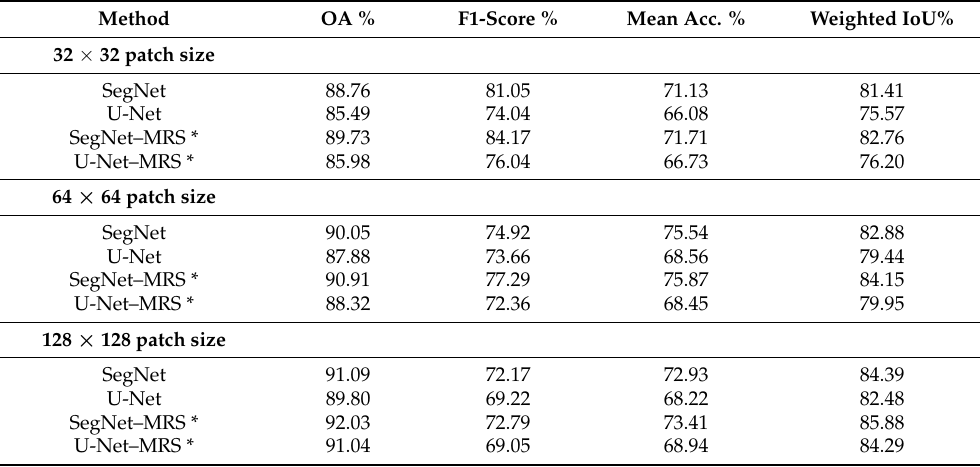
Table 15. Experimental results for ZH 16 image of the Zurich Summer dataset.